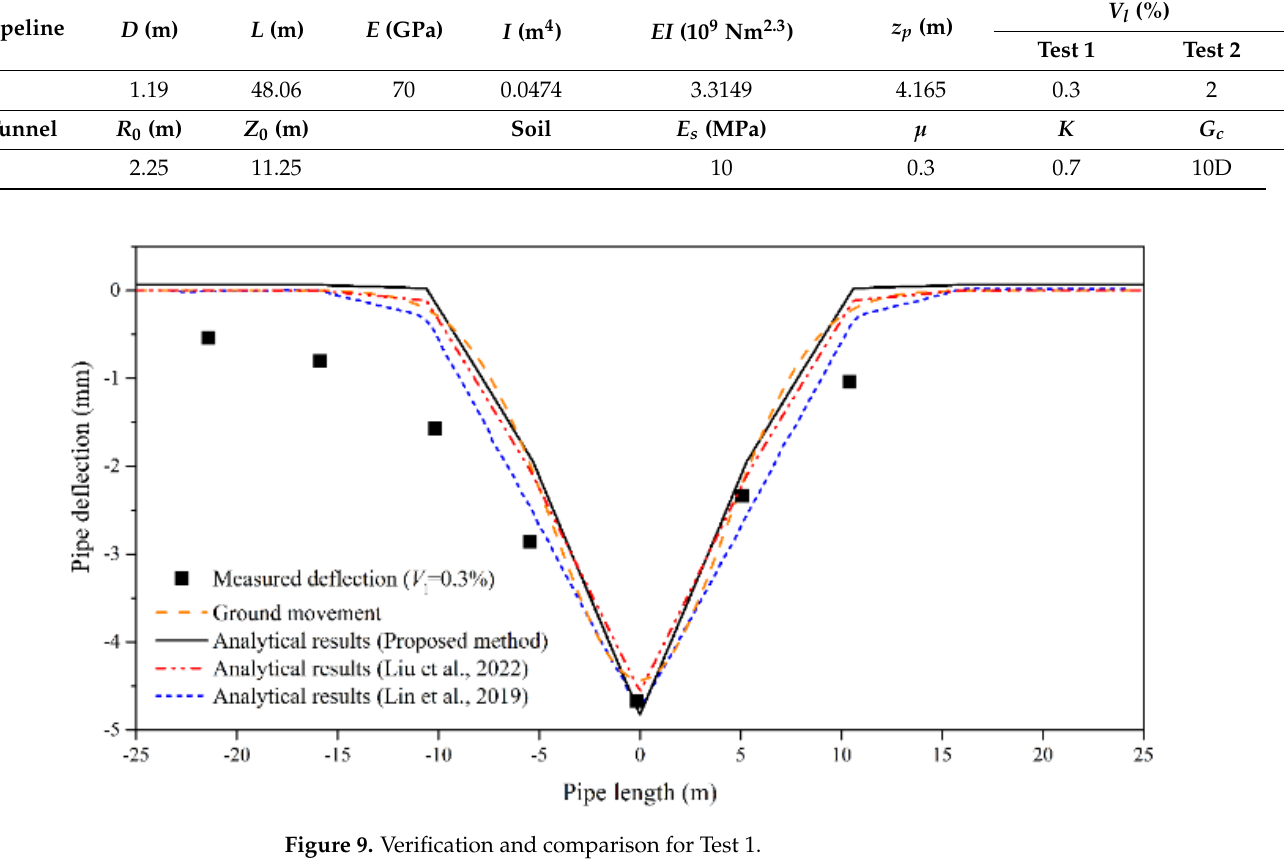
Figure 9. Verification and comparison for Test 1.